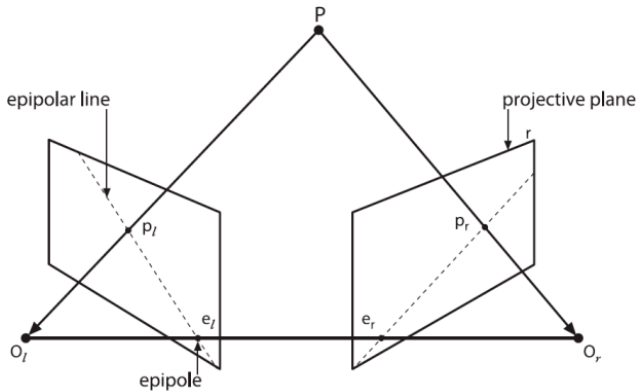
Figure 11. Epipolar plane in a dual-camera system.